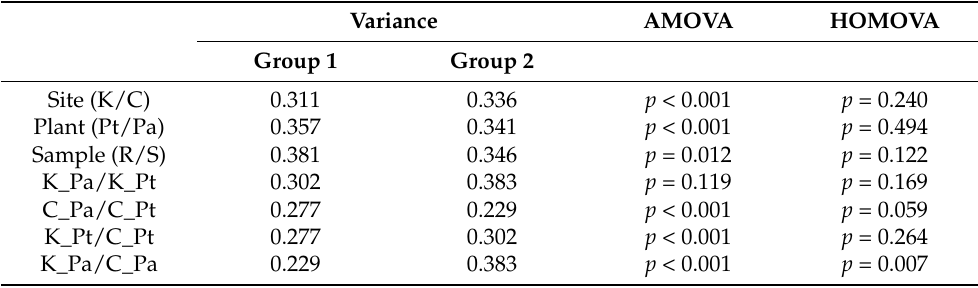
Figure 4. Exemplary trees visualizing Spearman’s correlation coefficient between phenol contamina- tion and soil pH KCl and edge masses. Blue and red colors indicate positive and negative correlation of placements with the phenol and pH KCl , respectively ( A ). Correlation trees for the other physic- ochemical factors (PAHs, soil moisture, SOM, N tot , pH water ) are shown in Figure S7. Edge PCA demonstrating the spatial distribution of the soil (S) and root (R) AMF communities associated with P. trivialis (Pt) and Ph. australis (Pa) collected from the contaminated (K) and uncontaminated (C) sites based on the differences in placements across the edges of the phylogenetic tree ( B ). A heat-map summarizing the results of imbalance k-means clustering. Color intensity is proportional to the number of samples representing the root (R) and soil (S) AMF communities associated with P. trivialis (PT) and Ph. australis (PA) at the contaminated (K) and the uncontaminated site (C) that are assigned to clusters represented by the AMF species of the highest Euclidean distance of the edge imbalance between samples ( C ). Table 2. The results of the non-parametric analysis of the homogeneity of molecular variance (HOMOVA) and AMOVA indicating the significant differences in the structure of soil (S) and root (R) AMF communities associated with P. trivialis (Pt) and Ph. australis (Pa) collected from the contaminated (K) and uncontaminated (C)